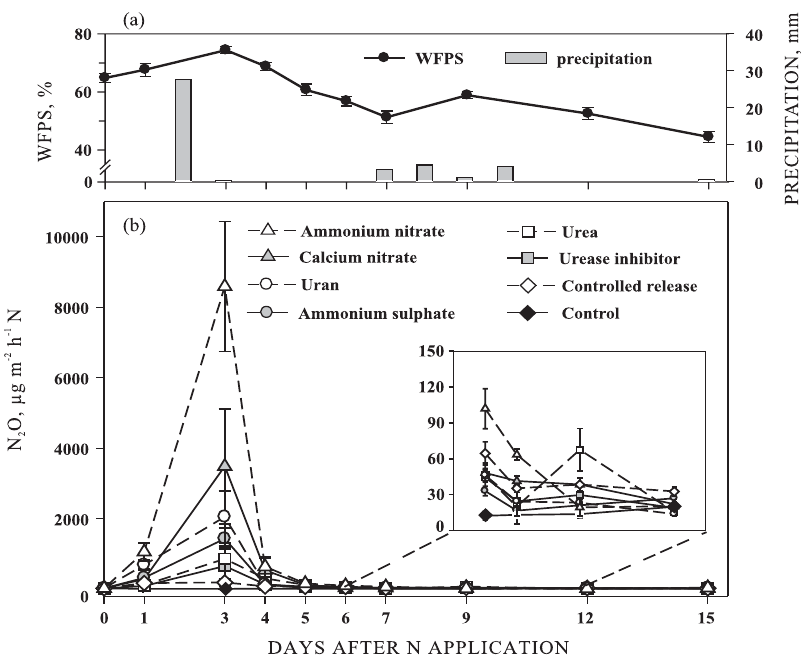
emissionFigure 1. Rainfall, water-filled pore space (WFPS) at the 0 to 0.10 m soil layer (a) and N from soil (b) for the 15 days period after application of the nitrogen fertilizers to a Gleysol in the South of Brazil. Vertical bars mean standard deviation of the mean ( n